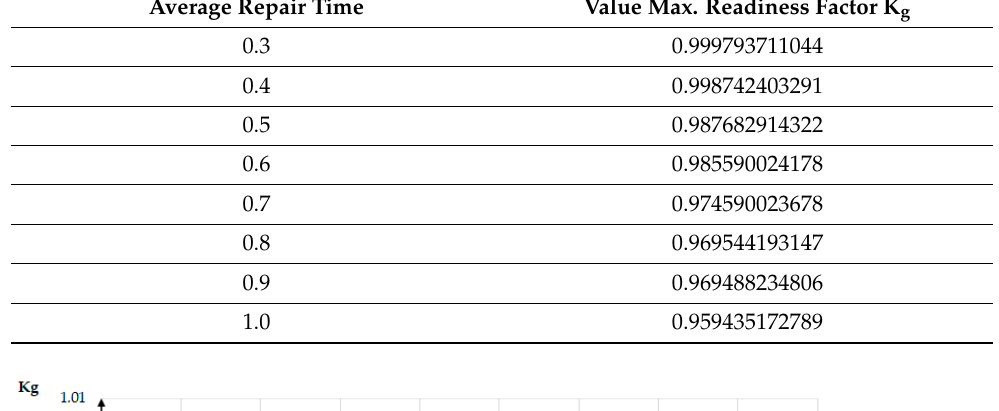
Table 1. Max. value readiness factor K g .